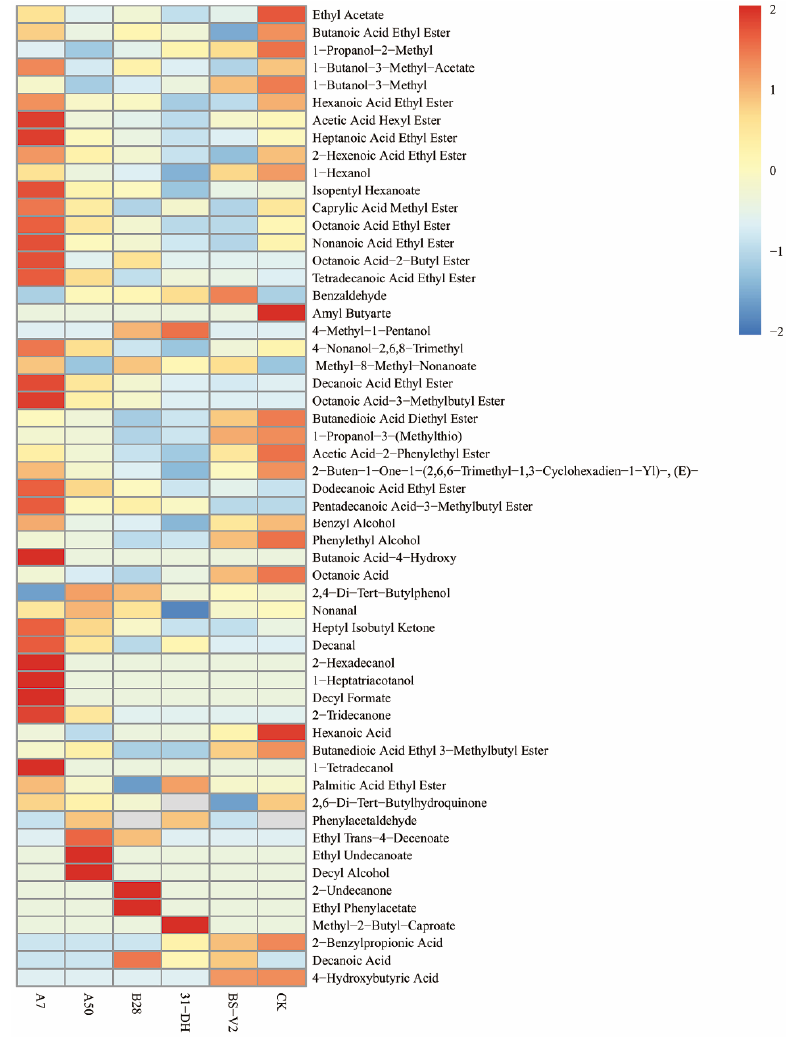
Figure 9. Cluster diagram of volatile compounds for cabernet sauvignon wines.